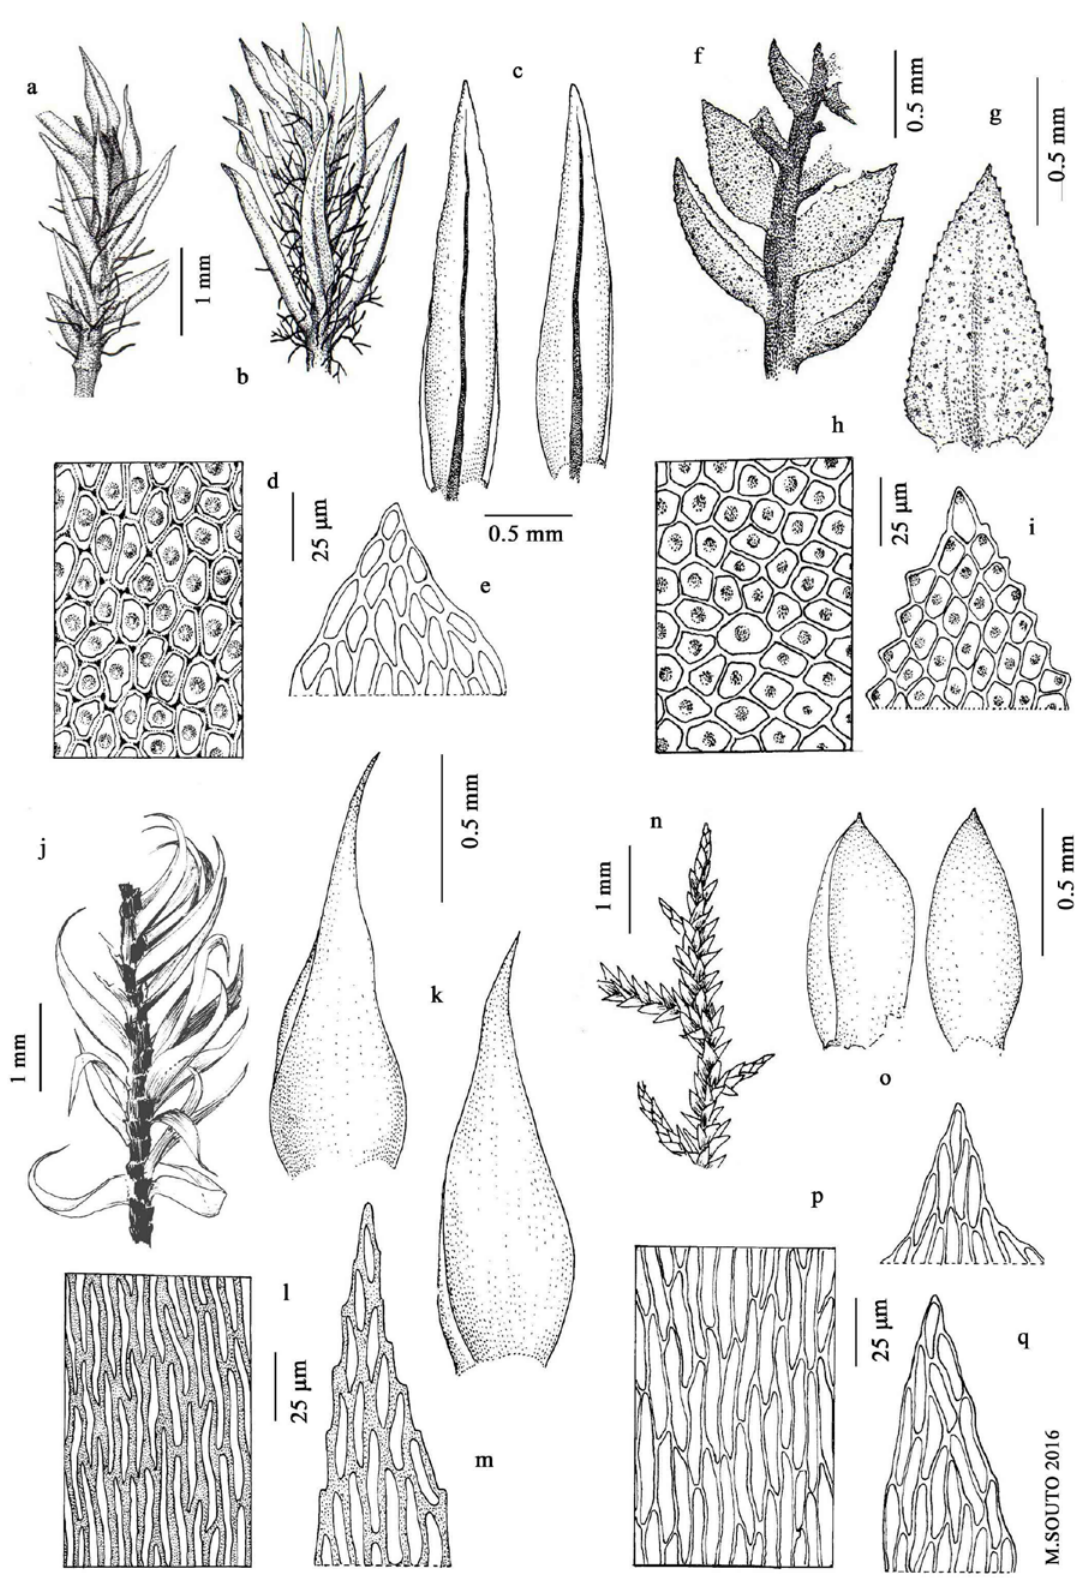
Figure A3 . Aulacomnium palustre : a, b) fragment of stem with dense tomentum and leaves, c) leaves, d) mid-leaf cells, e) leaf apex; Thuidium tamariscinum : f) fragment of stem with leaves, g) leaf, h) mid-leaf cells , i) leaf apex; Hypnum cupressiforme : j) shoot fragment, k) leaf, l) mid-leaf cells , m) leaf apex; Calliergonella cuspidata : n) branches with leaves, o) leaves, p) mid-leaf cells, q) leaf